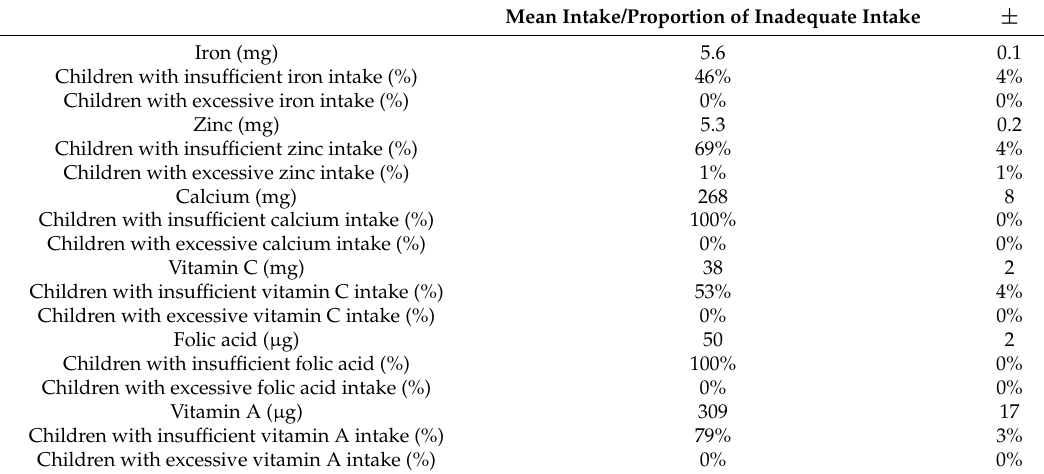
Table 2. Mean micronutrient daily intake (adjusted for within-person variability) and prevalence of insufficient and excessive micronutrient daily